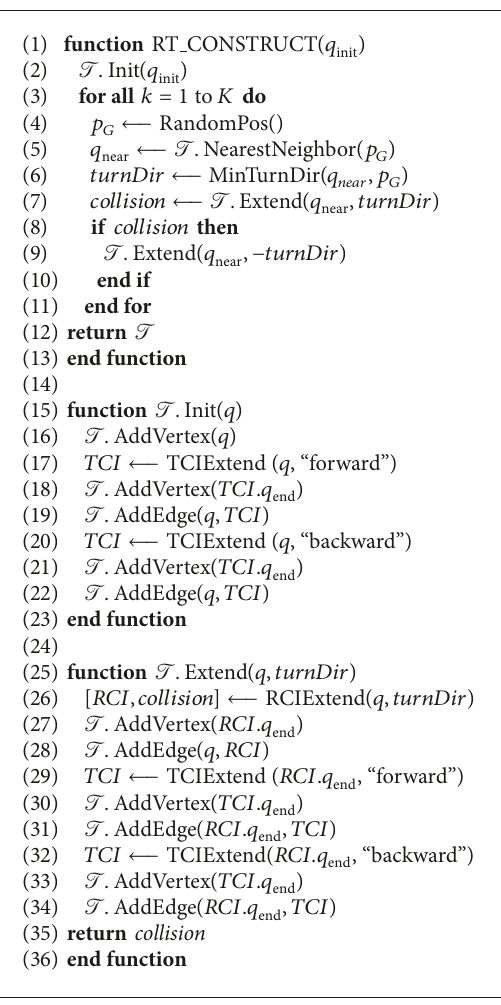
Algorithm 2: Construction of an RT-tree.